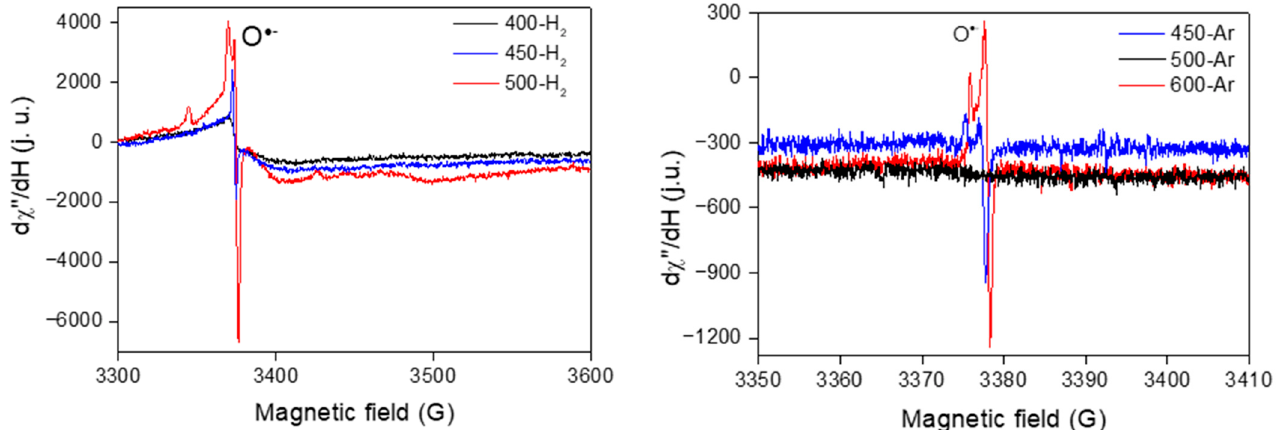
Figure 2. EPR spectra of TiO 2 samples heat-treated at 400–600 °C under hydrogen ( left ) and argon ( right ). For samples reduced in hydrogen, there was one narrow signal at g = 2.012, which